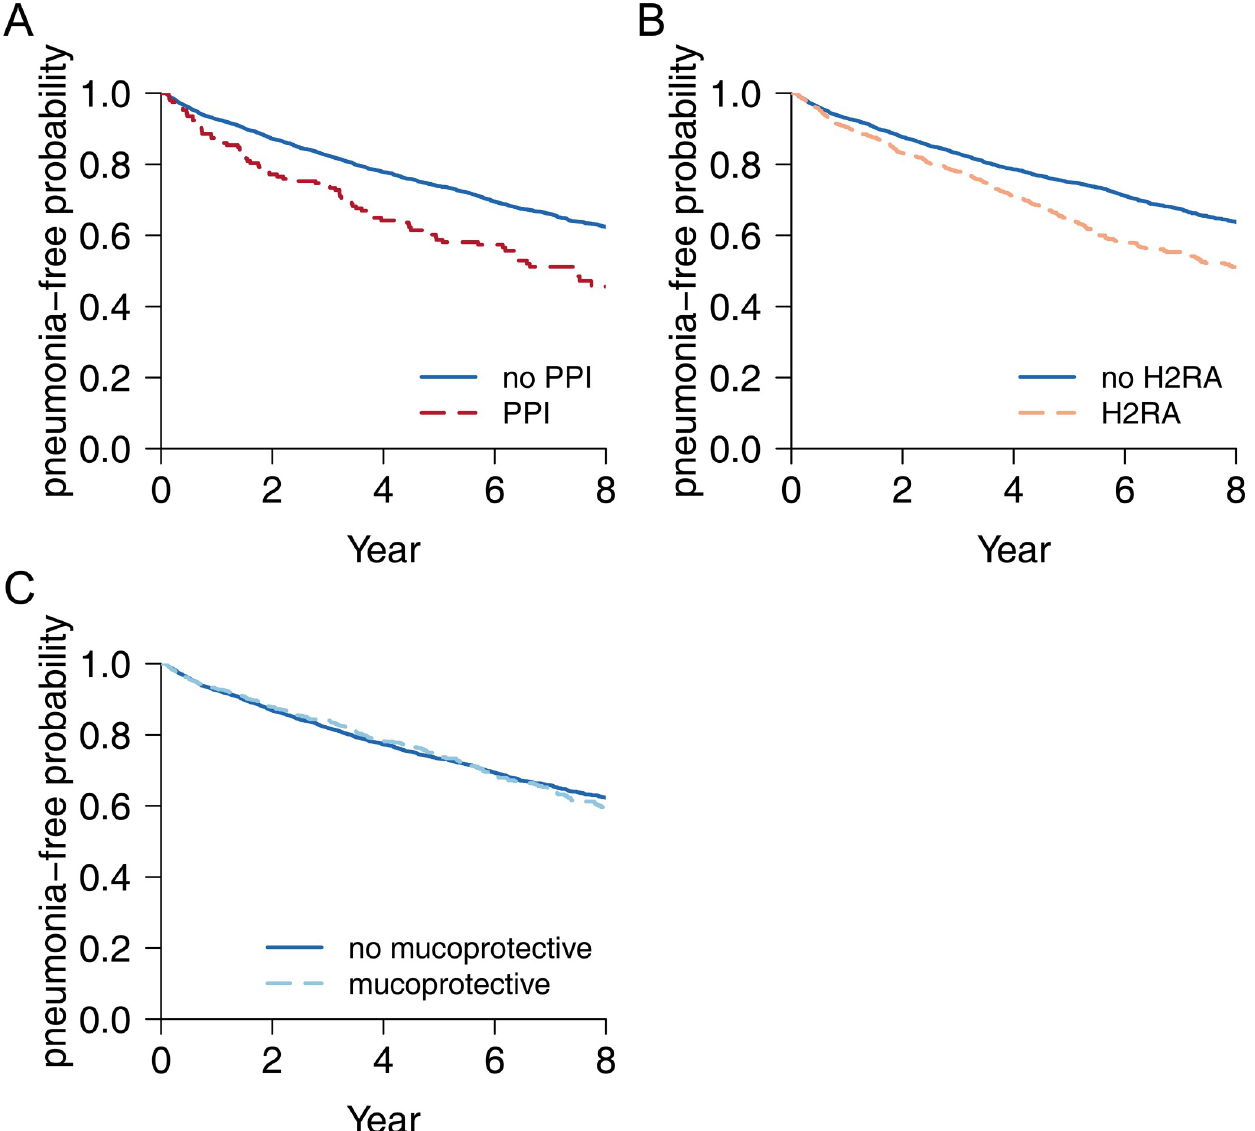
Fig 3. Estimated pneumonia-free probability according to the use of medications during post-stroke follow-up period. Each plot illustrates estimated pneumonia-free survival curves according to the use of PPI (A), H2RA (B), and mucoprotective agents (C) during the followed-up period after stroke. Mucoprotective agents include rebamipide, teprenone, irsogladine, ecabet, polaprezinc, sofalcone, sucralfate, and misoprostol. Abbreviations: H 2 RA, H 2 - receptor antagonist; PPI, proton-pump inhibitor.